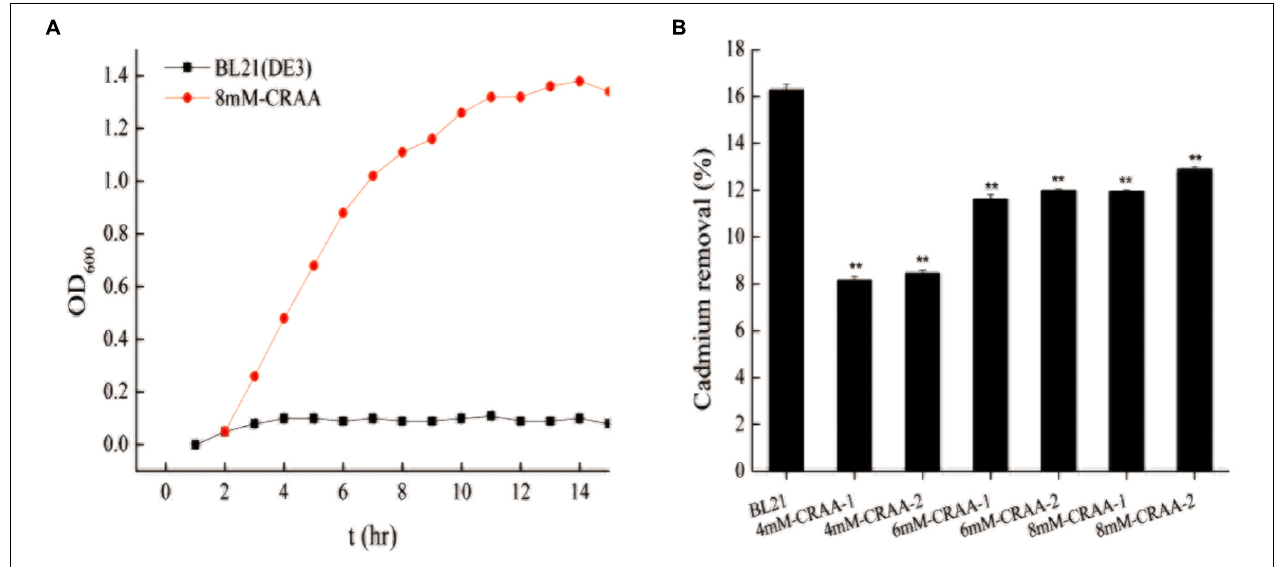
FIGURE 3 | Growth curve of 8mM-CRAA in 1.2 mM Cd 2 + and the cadmium removal capacity of different strains. (A) Growth curve of 8mM-CRAA in 1.2 mM Cd 2 + ; BL21(DE3) was used as a negative control. (B) Cadmium removal capacity of different strains, with BL21 and pUC19-GFP as controls; ∗∗ p <